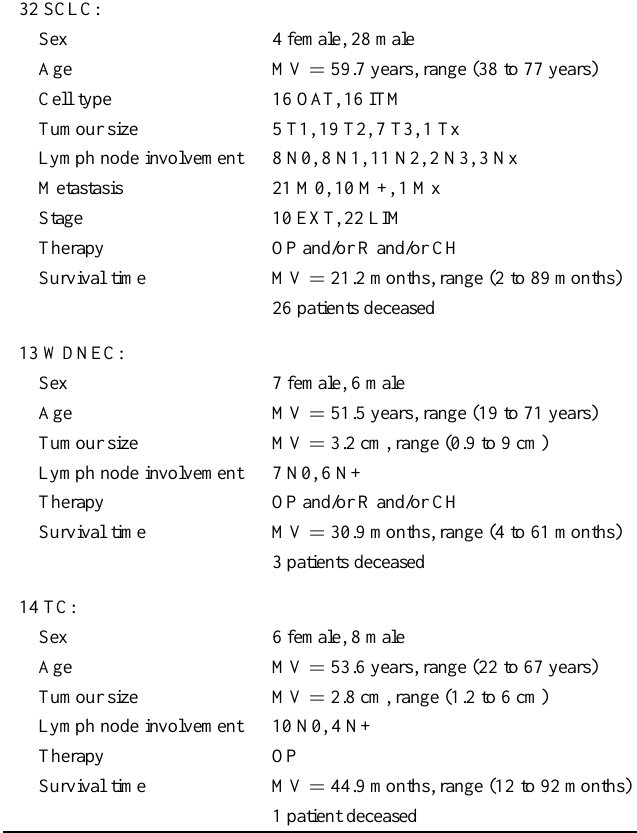
Clinical data of 59 tumour patients of the lung separately for each tumour